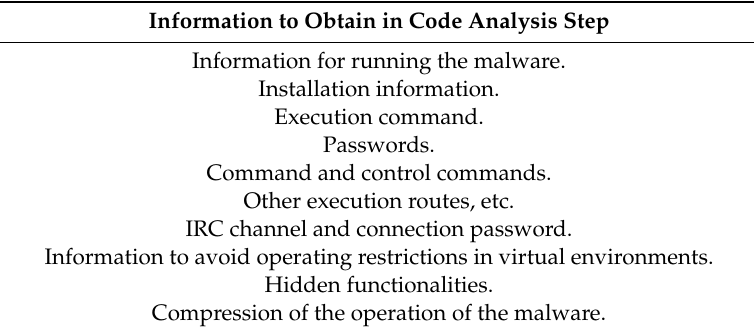
Table 4. Information to obtain in classification